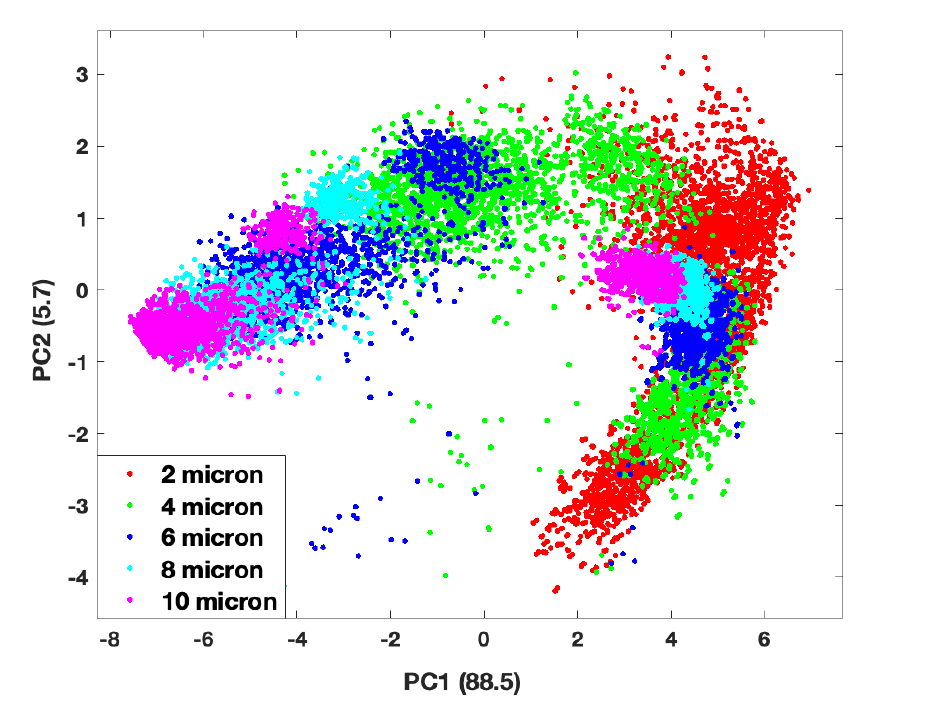
Figure 4. Scatter plot of the scores values for first 2 principal components of the forward scattering dataset by cluster size.